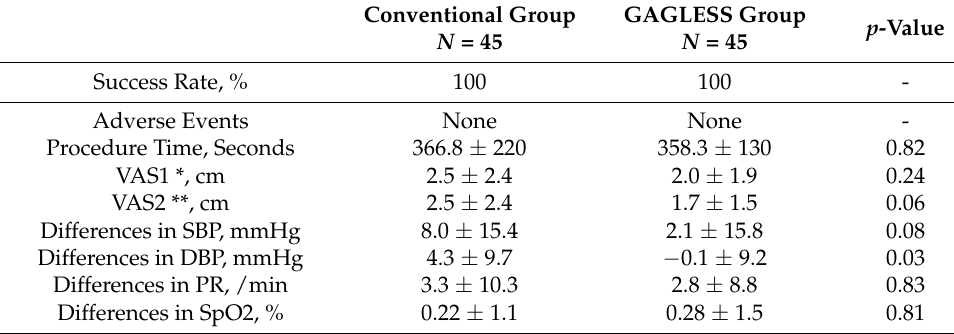
Table 2. Results of the primary and secondary